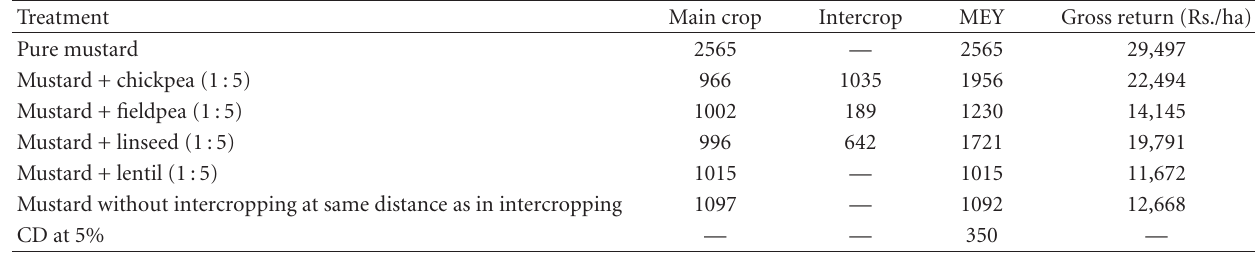
Table 6: Seed yield (kg/ha), mustard equivalent yield (MEY), and gross return (Rs./ha) as influenced by various intercropping combinations under rainfed conditions at